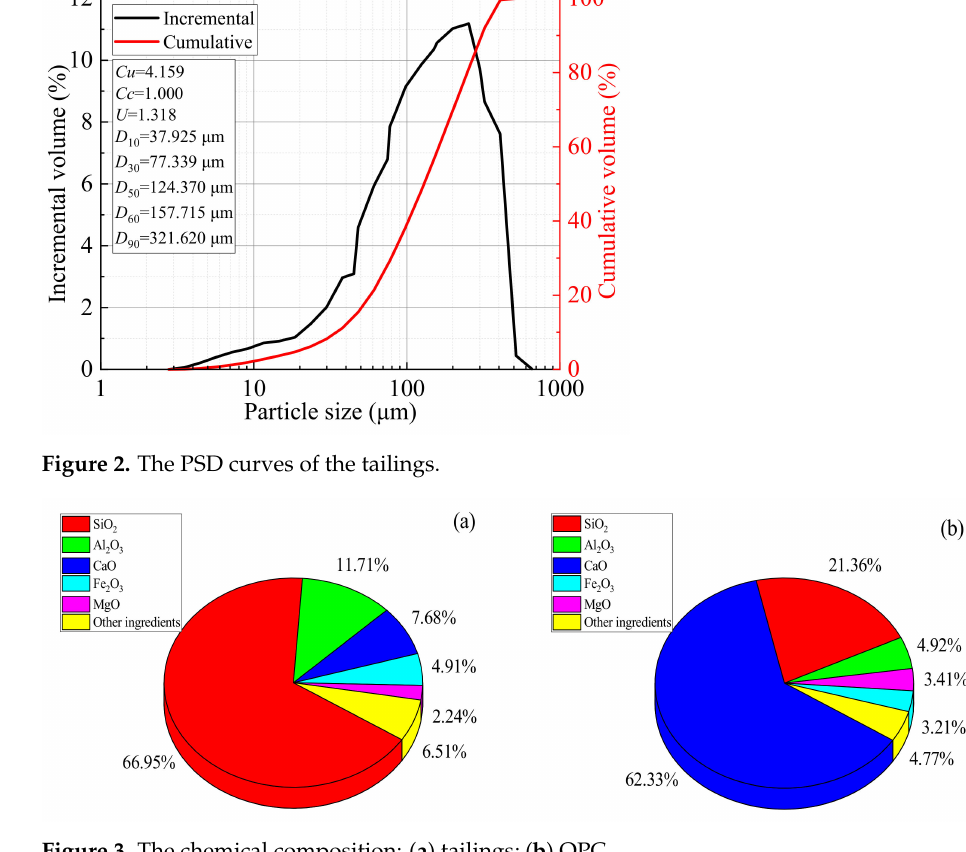
Figure 3. The chemical composition: ( a ) tailings; ( b ) OPC.